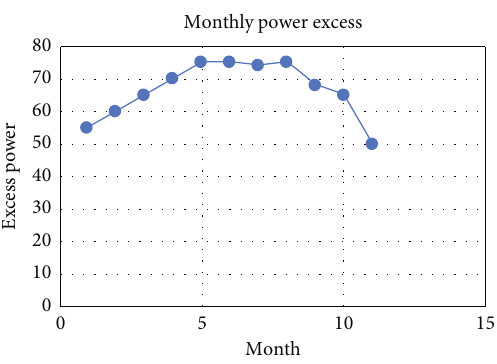
Figure 10: Excess PV power on monthly.